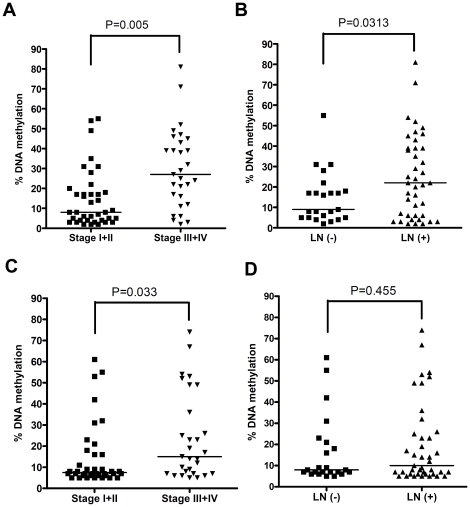
MT3 methylation of is associated with advanced tumor stage and lymph node metastasis.
A) Increased DNA methylation of MT3 promoter R2 (−127 to −8 sites) correlates with advanced tumor staging (P = 0.005). B) DNA methylation of MT3 promoter R2 (−127 to −8 sites) correlates with lymph node metastasis (P = 0.03). C) DNA methylation of MT3 promoter R3 (+28 to +344 sites) correlates with tumor staging (P = 0.03). D) DNA methylation of MT3 promoter R3 (+28 to +344 sites) does not correlate with lymph node status (P = 0.4).